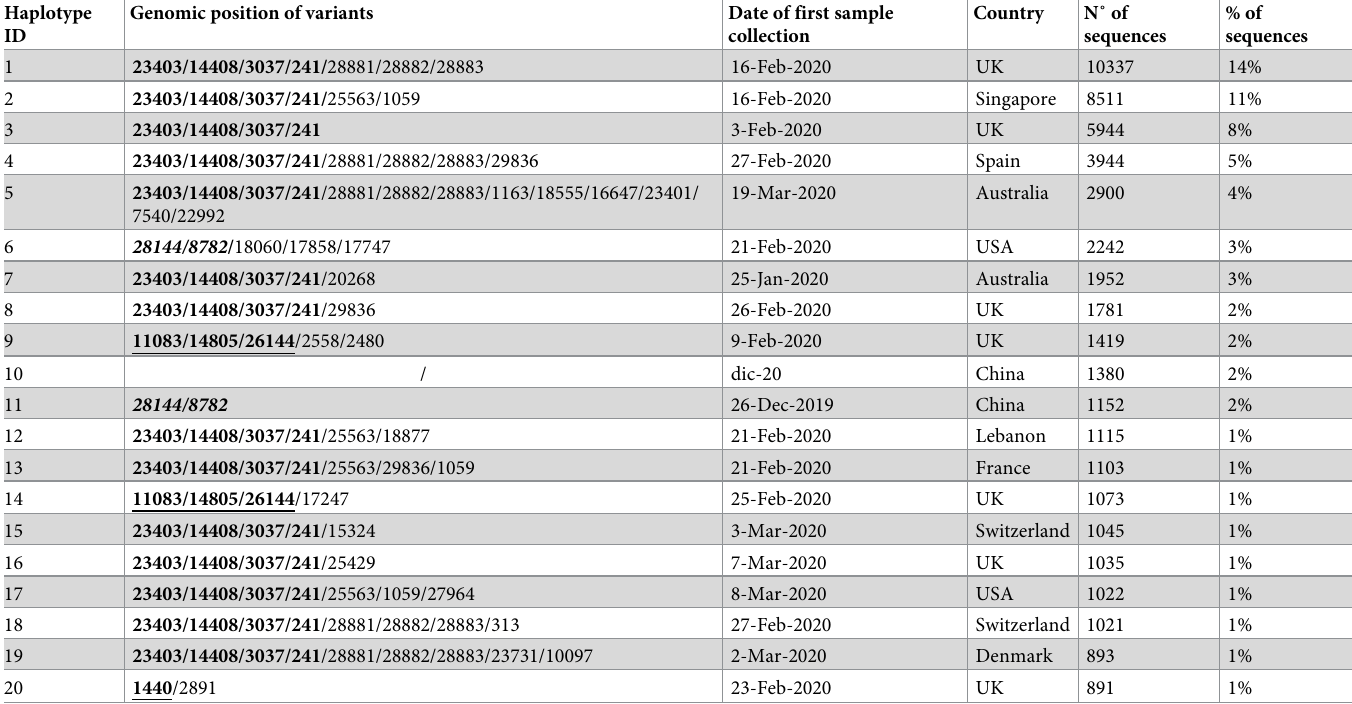
Table 4. Most frequent SARS-CoV-2 haplotypes: Frequency and distribution. In bold the variants charactering Clade 1, in italics Clade 2, underlined Clade 3 and dou- ble underlined Clade 4. Haplotype Genomic position of ID